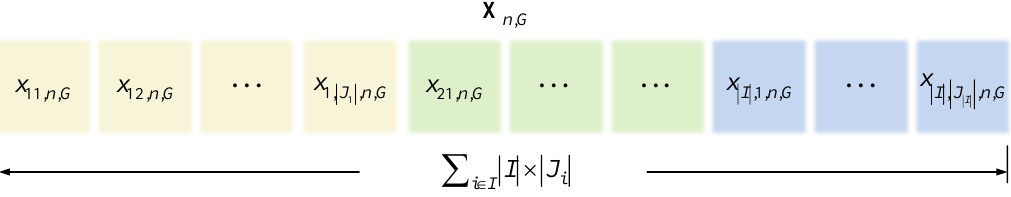
Figure 5. Schematic diagram of the encoding structure.